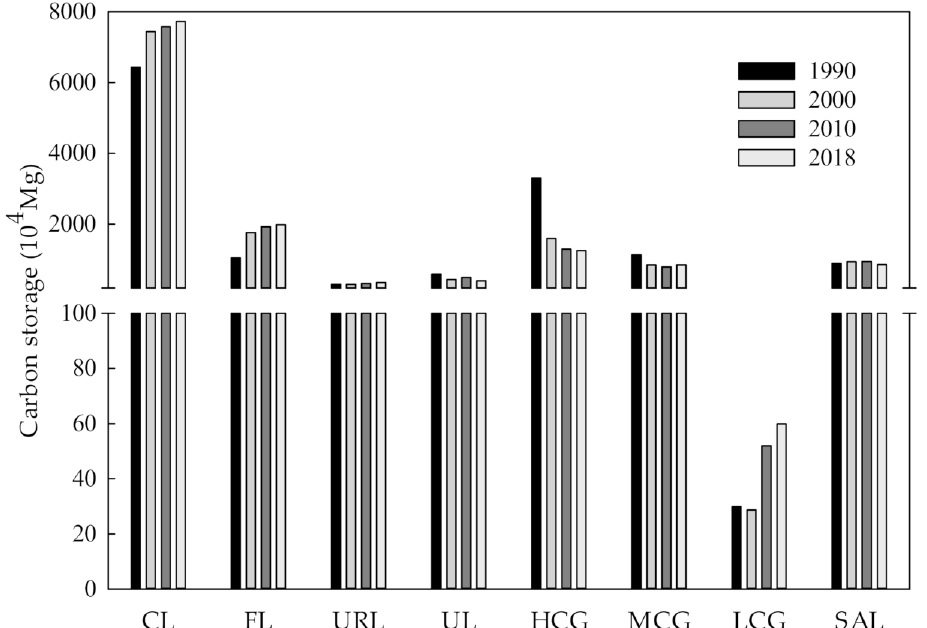
Figure 3. Total carbon storage of different land use types from 1990 to 2018. CL, Cultivated land; FL, Forest land; URL, Urban and rural construction land; UL, Unused land; HCG, High-cover grassland;